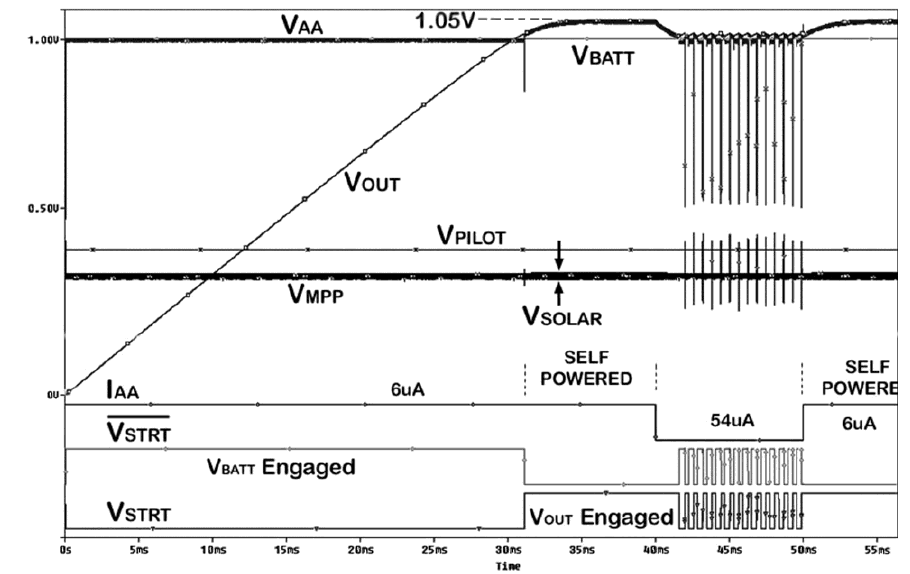
Figure 8. Simulation result of the full operating cycles of the